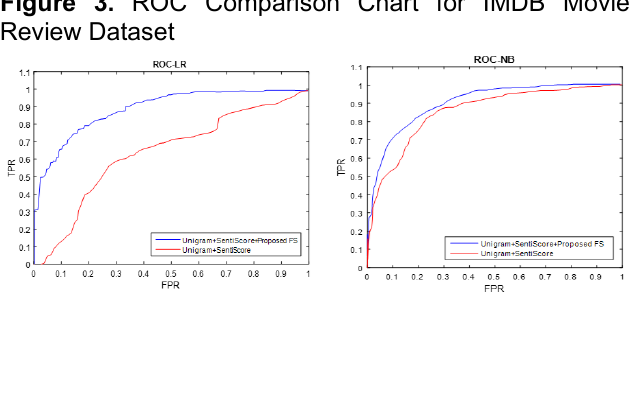
Figure 3. ROC Comparison Chart for IMDB Movie